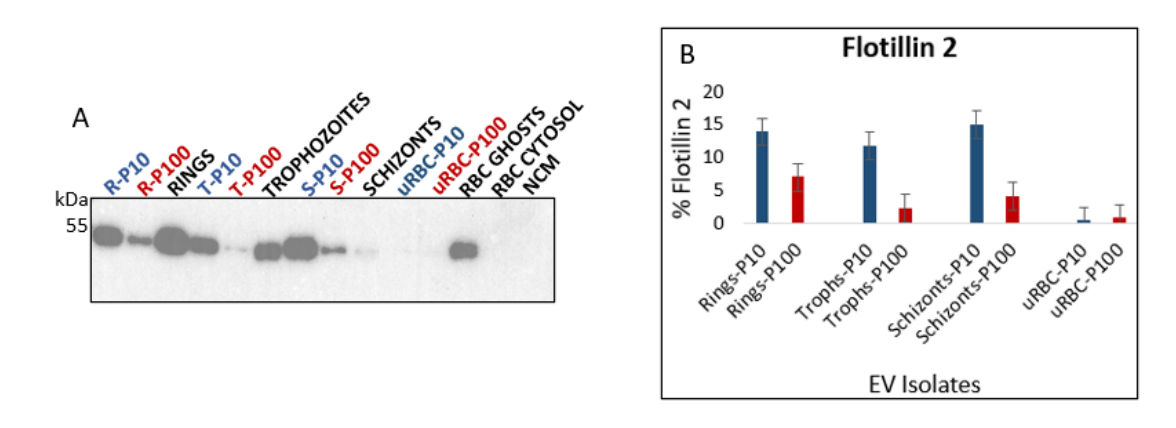
Figure 9. ( A ) Western blot analysis of flotillin 2 in EVs (blue and red) and lysates of parent cells from which the EVs were released (black). Flotillin 2 (49 kDa) is a cytosolic membrane-associated protein that is commonly found in EVs. ( B ) Densitometric analysis of flotillin 2. Flotillin 2 is enriched in iRBC P10 compared to iRBC P100 EVs. All iRBC EVs have significantly more flotillin 2 than uRBC EVs. P10 EVs–blue, P100 EVs–red, cell lysates and controls–black. R-rings, T-trophozoites, S-schi- zonts, U-uninfected, NCM-nonconditioned media.